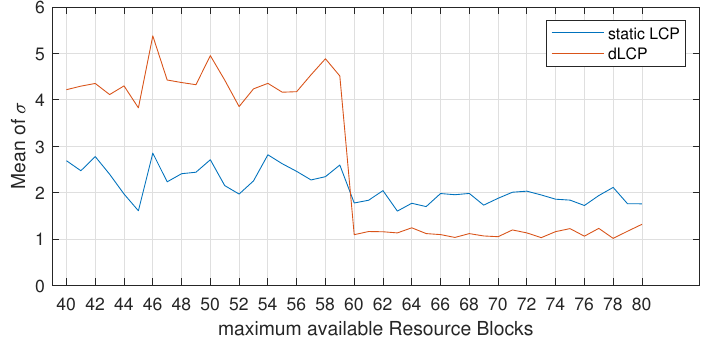
Figure 10. Jitter for TSN Packet Size of 800 bytes.